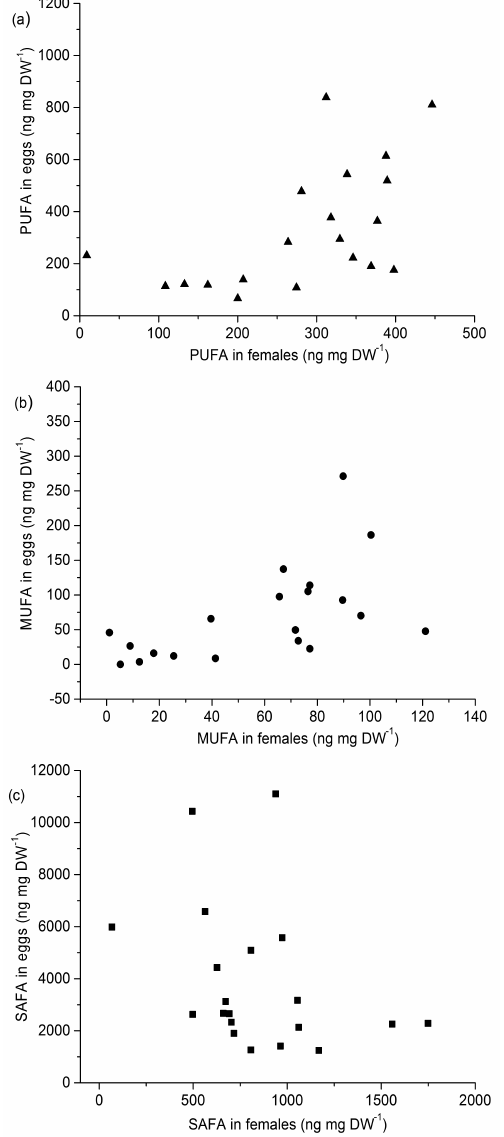
Figure 3. Fatty acids; (a) PUFA, (b) MUFA, and (c) SAFA content of females and